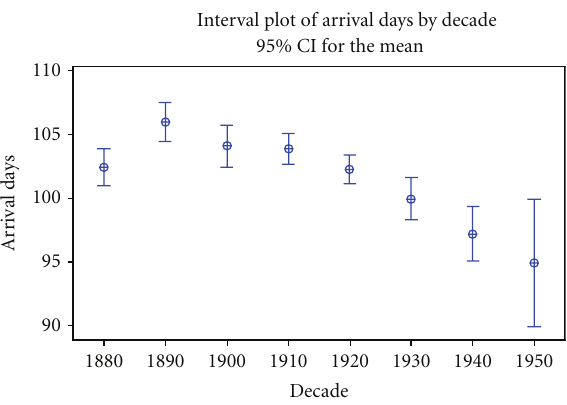
Figure 3: Interval plot for the mean arrival days for decades 1880– 1950. Intervals show the 95% confidence interval for the mean decadal arrival dates. Arrival days are expressed in “day of year” and corrected for leap years; for example, “90” corresponds to March 29. The sample sizes for decades are 501 (1880s), 565 (1890s), 700 (1900s), 1126 (1910s), 1152 (1920s), 738 (1930s), 444 (1940s), 119